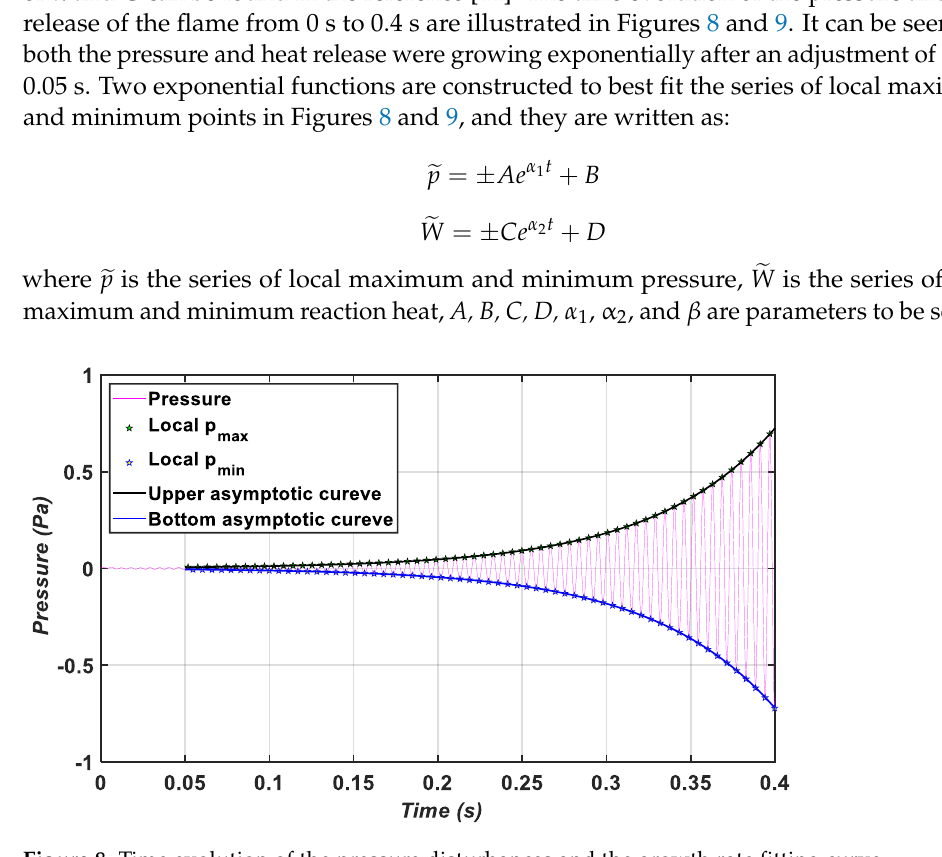
Figure 8. Time evolution of the pressure disturbances and the growth rate fitting curve.